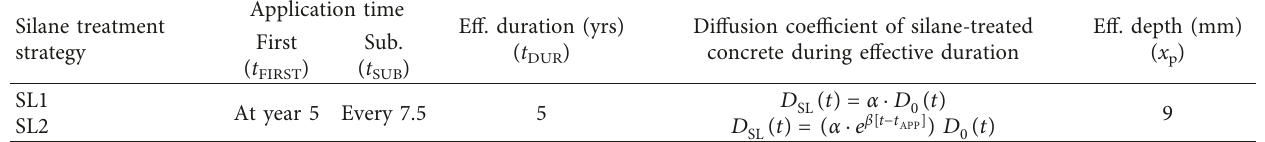
Table 1: Application time, effective duration, and effect of silane treatment.